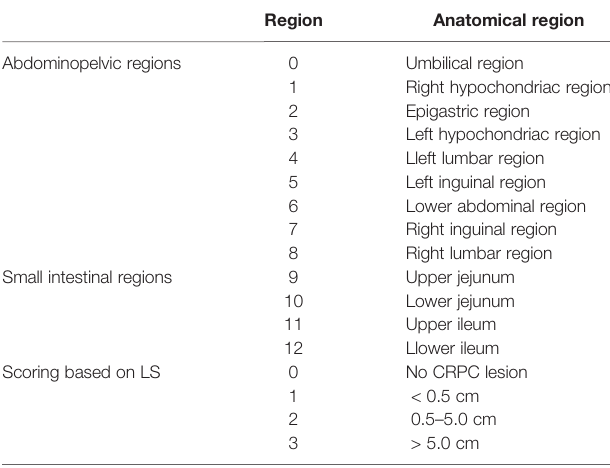
TABLE 1 | The PCI grading system.